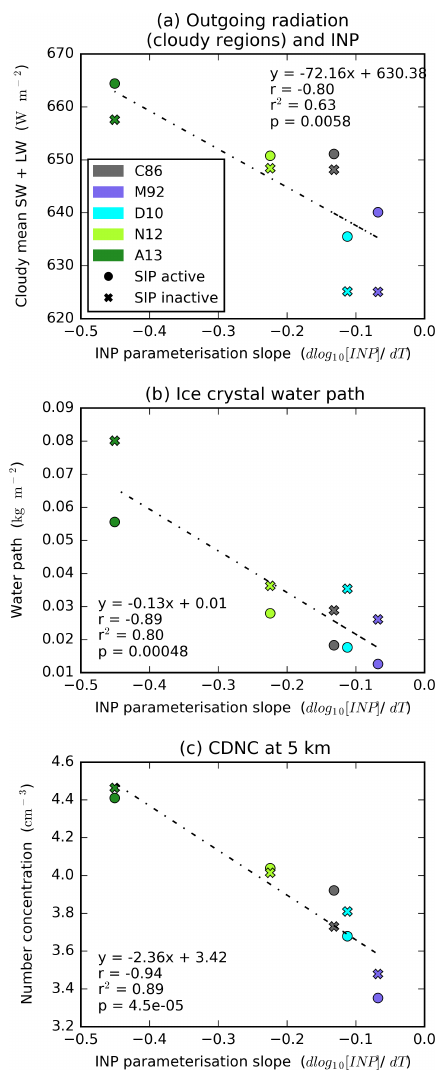
Figure 6. Outgoing daytime (10:00–17:00UTC) radiation from cloudy regions and the INP parameterisation slope. Scatter plots of the INP parameterisation slope and total daytime outgoing radi- ation from cloudy regions (a) , the in-cloud mean ice crystal (cloud ice only) water path (b) and the in-cloud cloud droplet number con- centrations at the start of the mixed-phase region (5km) (c) . Also shown are the respective regression lines ( n = 10) and associated statistical